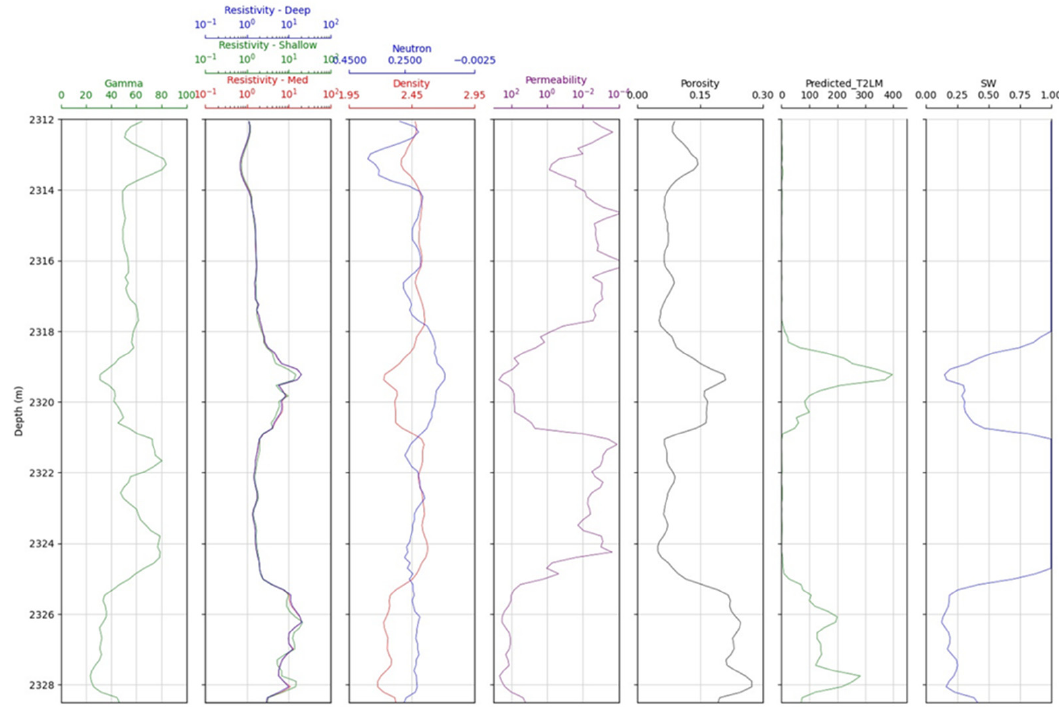
Figure 18. Predicted NMR T 2 LM for Reservoir A in new well.